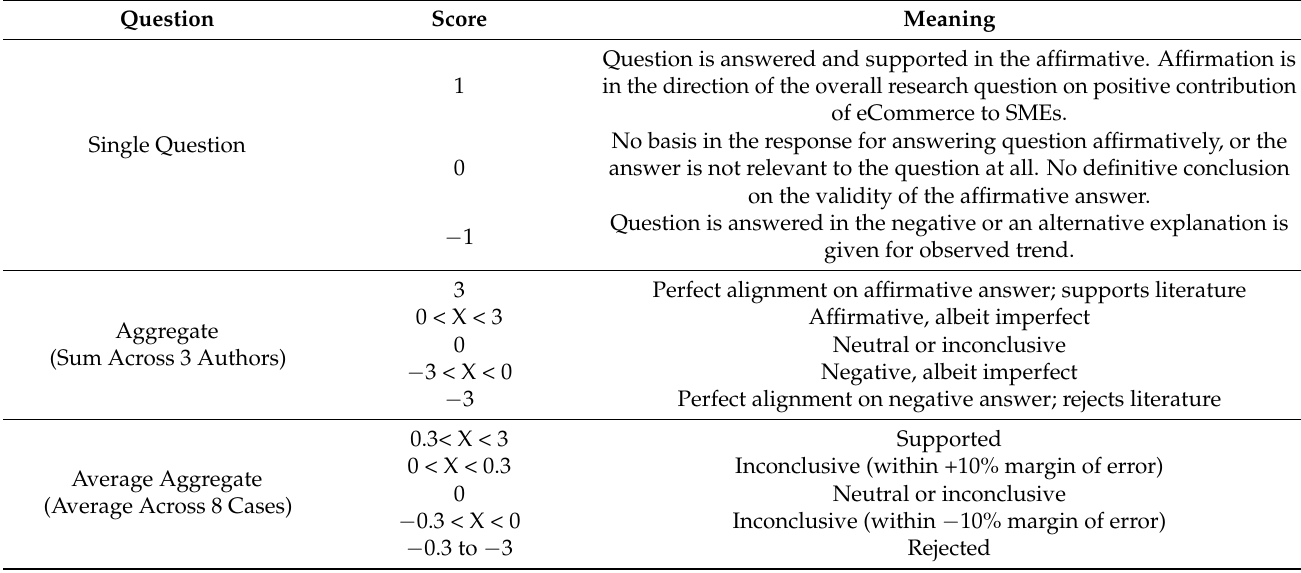
Table 6. Scoring responses to the interview